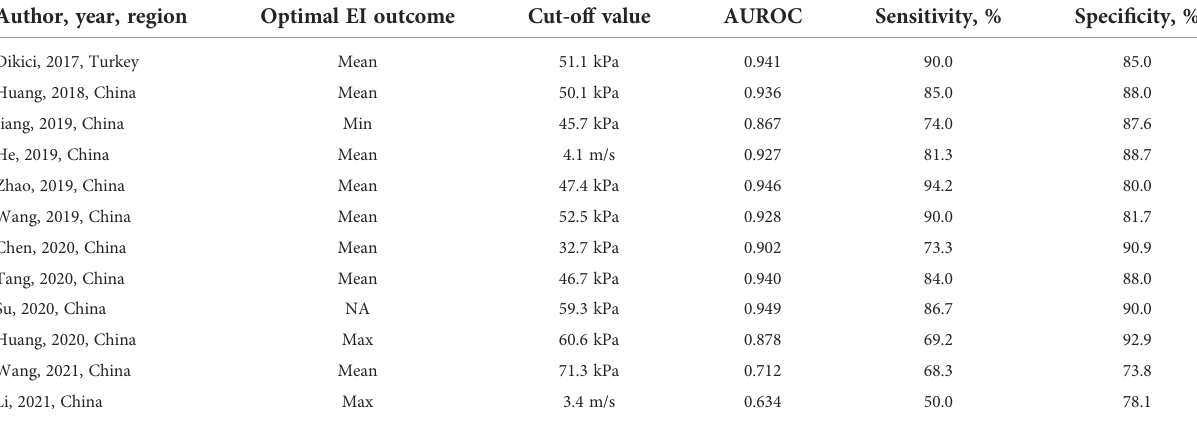
TABLE 3 Summary of diagnostic performance of SSI for diagnosing DPN. Author, year,